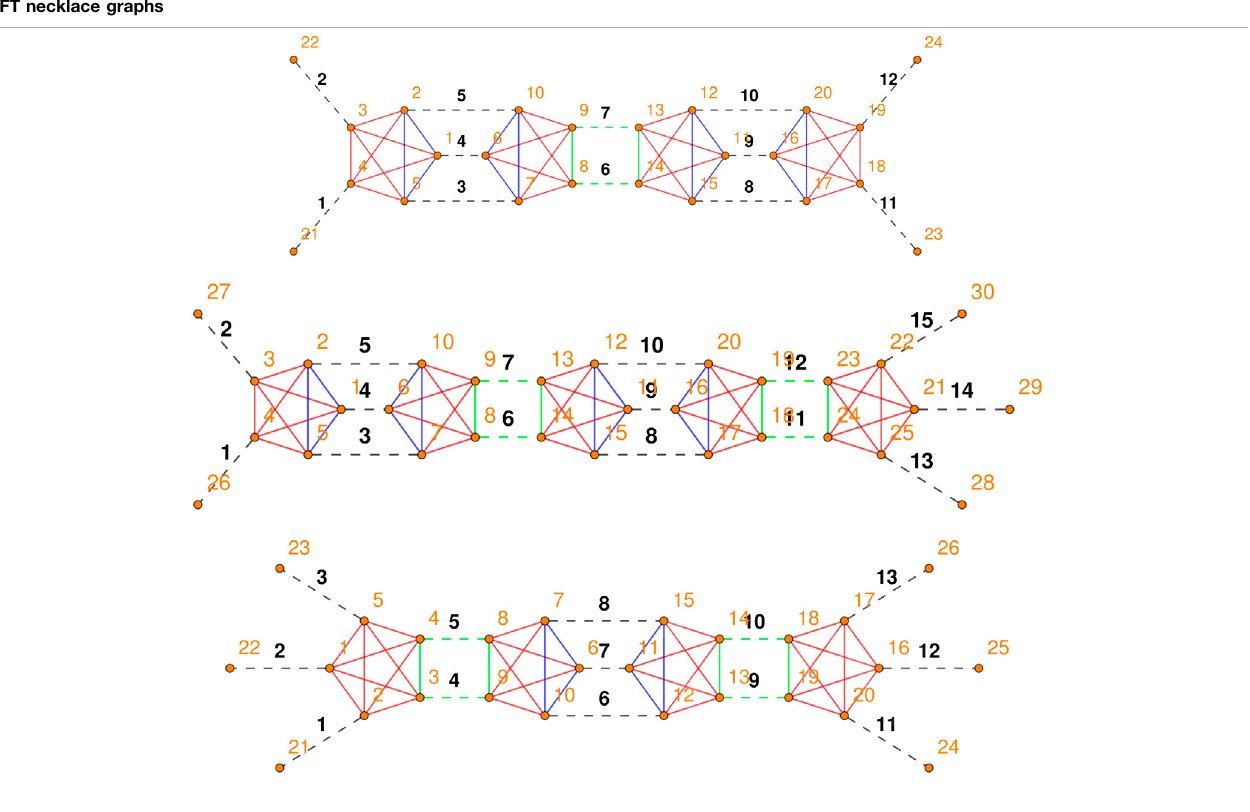
TABLE 8 | Examples of necklace diagrams contributing to the 4 − , 5 − and 6 − point functions. GFT necklace